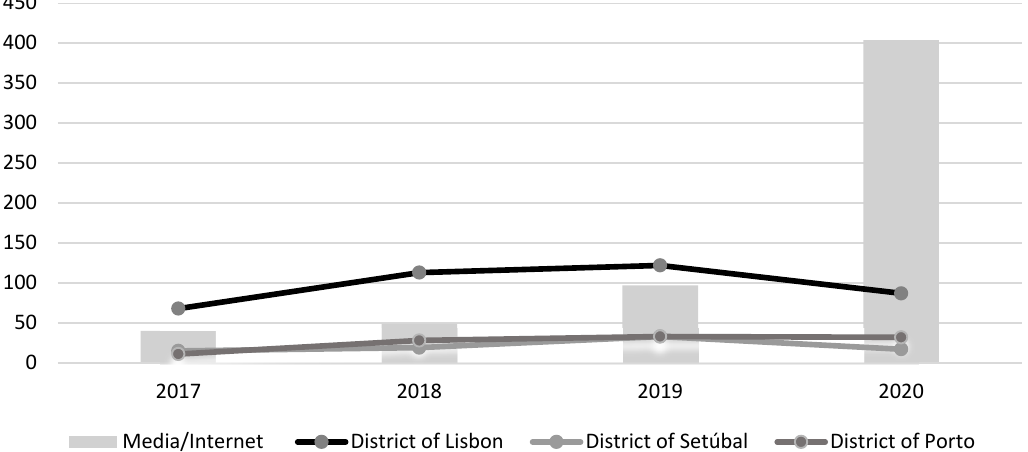
Figure 4. Complaints distributed by geographical areas/territories ( n )—2017–2020. Source: Data retrieved from CICDR (2017, 2018, 2019, 2020).